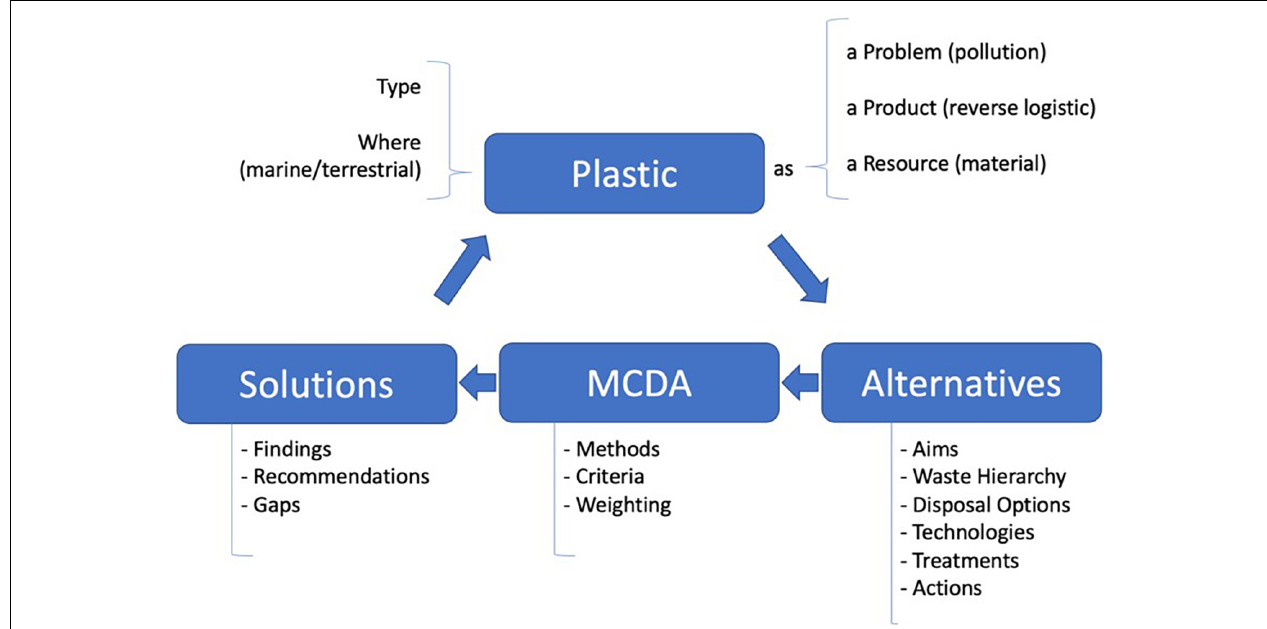
FIGURE 1 | Characteristics of the studies analyzed in this